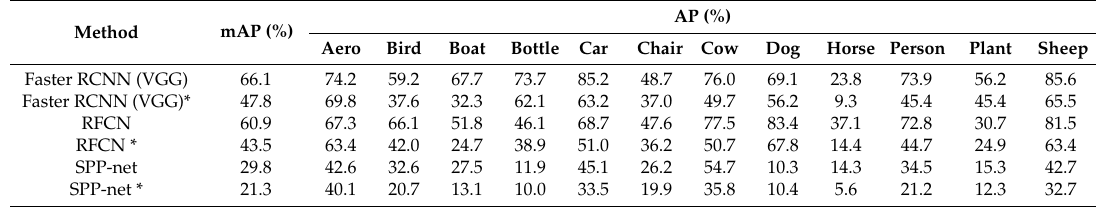
Table 3. Small object detection results for region-proposal-based methods on the VOC 2007